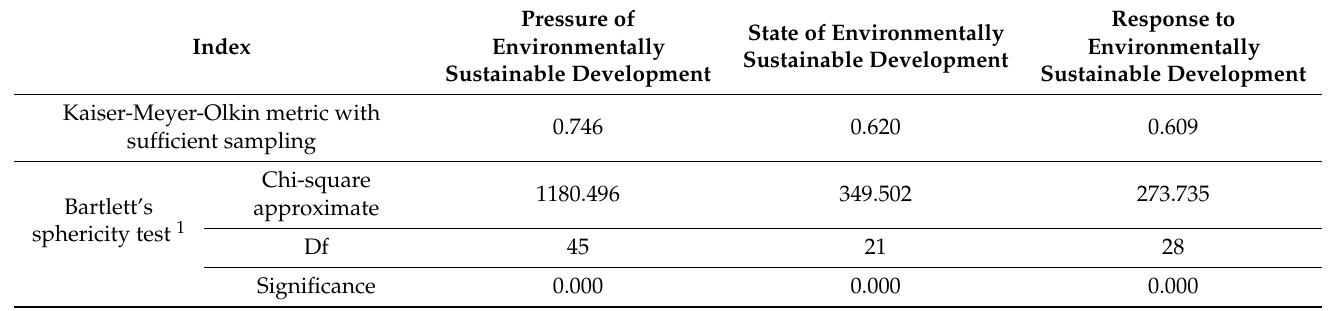
Table 5. Test of KMO and